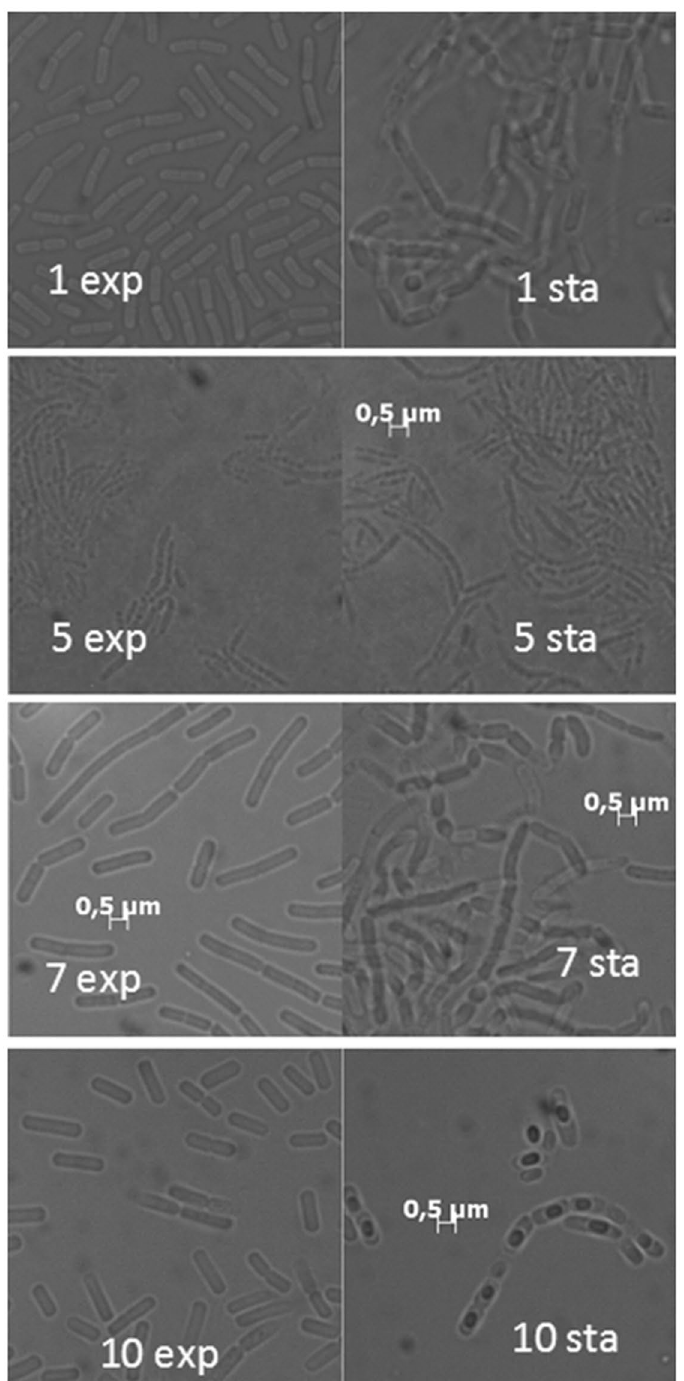
Figure 3. Bacterial morphologies of the four Bacillus species (samples 1, 5, 7 and 10) in exponential (exp) and stationary phase (sta). The pure cultures were grown in complete medium over night (exp) and three days (sta) at 28 °C. Microscopic analysis shows bacteria of the Genus Bacillus . Bar: 0,5